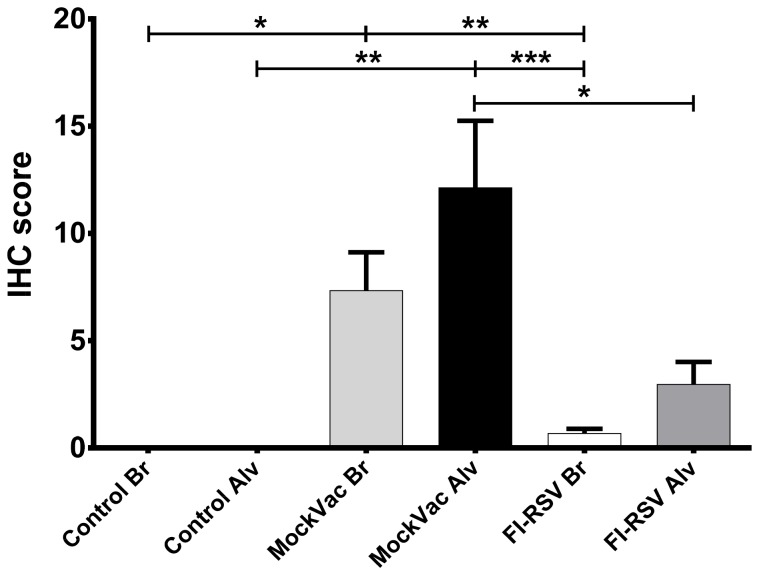
RSV antigen detected by immunohistochemistry (IHC).Control bronchioles and alveoli (Control Br and Control Alv) lack RSV antigen while bronchioles and alveoli of FI-RSV-vaccinated lambs had significantly reduced levels of RSV antigen compared to mock-vaccinated (MockVac) lambs. Control(s) n = 4; MockVac Br n = 4; MockVac Alv n = 4; FI-RSV Br n = 4; FI-RSV Alv n = 4. Error bars = SEM, *P<0.05, **P<0.01, ***P<0.001.